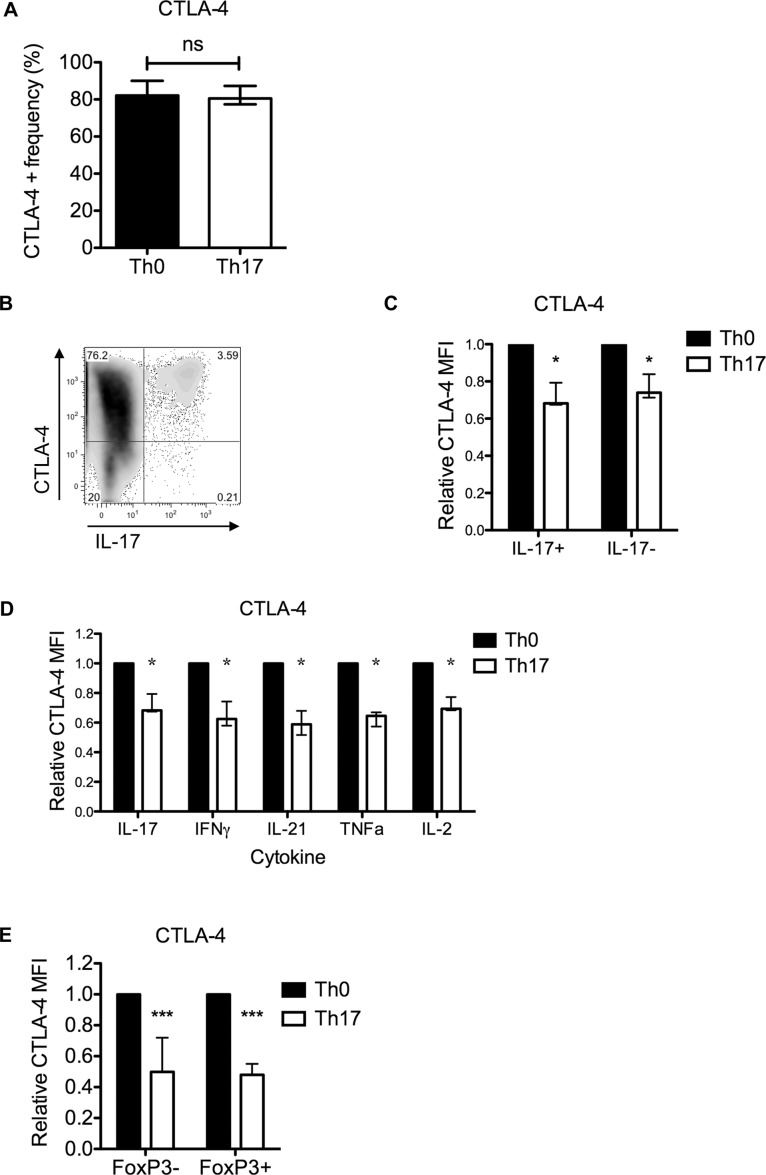
Suppression of CTLA-4 by Th17 polarising cytokines is not specific to IL-17+ T cells.CD4+CD25- T cells were stimulated in the presence of Th17 polarising cytokines for four days and assessed for IL-17, IFNγ, IL-21, TNFα, IL-2 or Foxp3 in combination with CTLA-4 by flow cytometry. A) Frequency of total CTLA-4+ cells. B) Representative bivariate FACS plot of CTLA-4 versus IL-17 for cells cultured under Th17 polarising conditions. C) CTLA-4 expression in CTLA-4+ T cells gated according to IL-17 expression. D) CTLA-4 expression by CTLA-4+ T cells that expressed IL-17, IFNγ, IL-21, TNFα or IL-2. E) CTLA-4 expression in CTLA-4+ T cells defined by FoxP3 expression. In C, D and E expression under Th17 conditions is expressed relative to the level under Th0 conditions. Data are summarised for n≥7 donors. Bars indicate median values and error bars show the semi interquartile range. Significance with respect to cells expressing the marker under Th0 conditions was tested by Wilcoxon matched paired tests. (* = P<0.05, ** = P<0.01, *** = P<0.001).